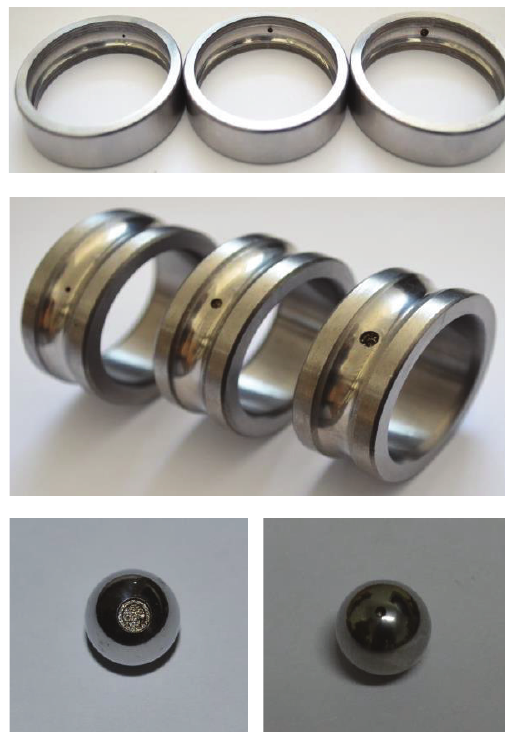
Figure 1: Bearing components with